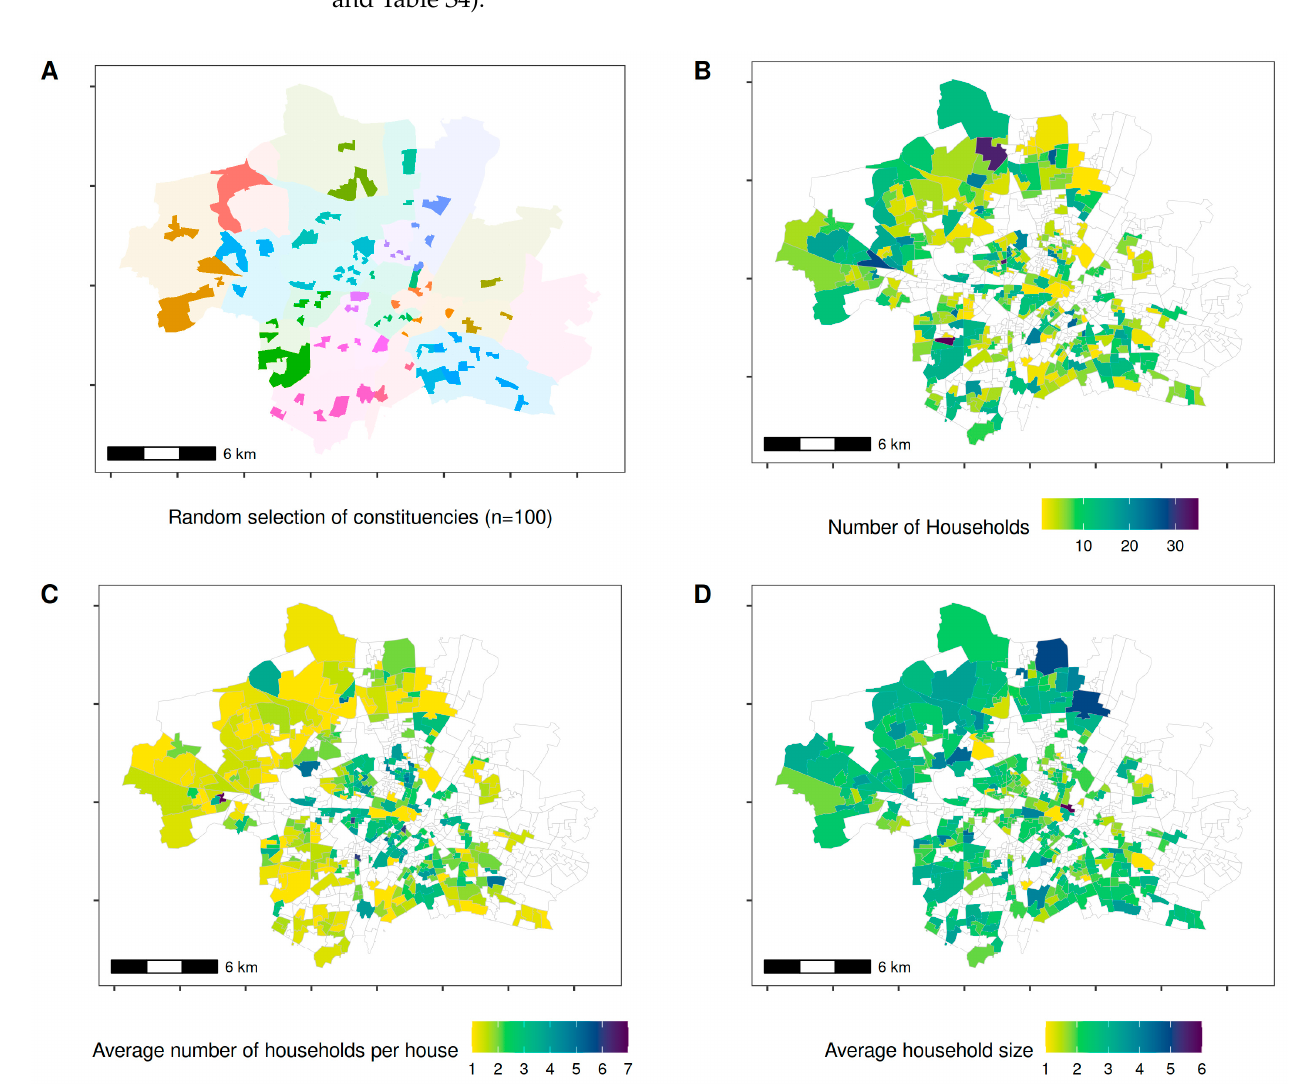
Figure 1. Selection procedure and geospatial distribution of the study population. ( A ) The municipality of Munich together with its districts (distinguished by different colors). The 100 selected start constituencies for the random walks are marked in the same color as the respective constituency but in a darker shade. ( B ) All 2994 included households and their respective 368 constituencies. ( C ) Average number of recruited households per building by constituency. ( D ) Average number of members per recruited household by constituency.